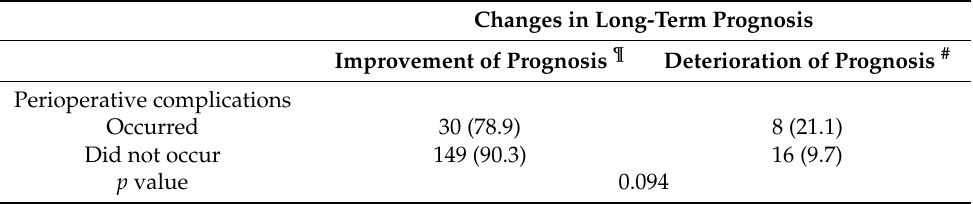
Table 6. Effect of perioperative complications on long-term prognosis. Changes in Long-Term Prognosis Improvement of Prognosis ¶ Deterioration of Prognosis # Perioperative